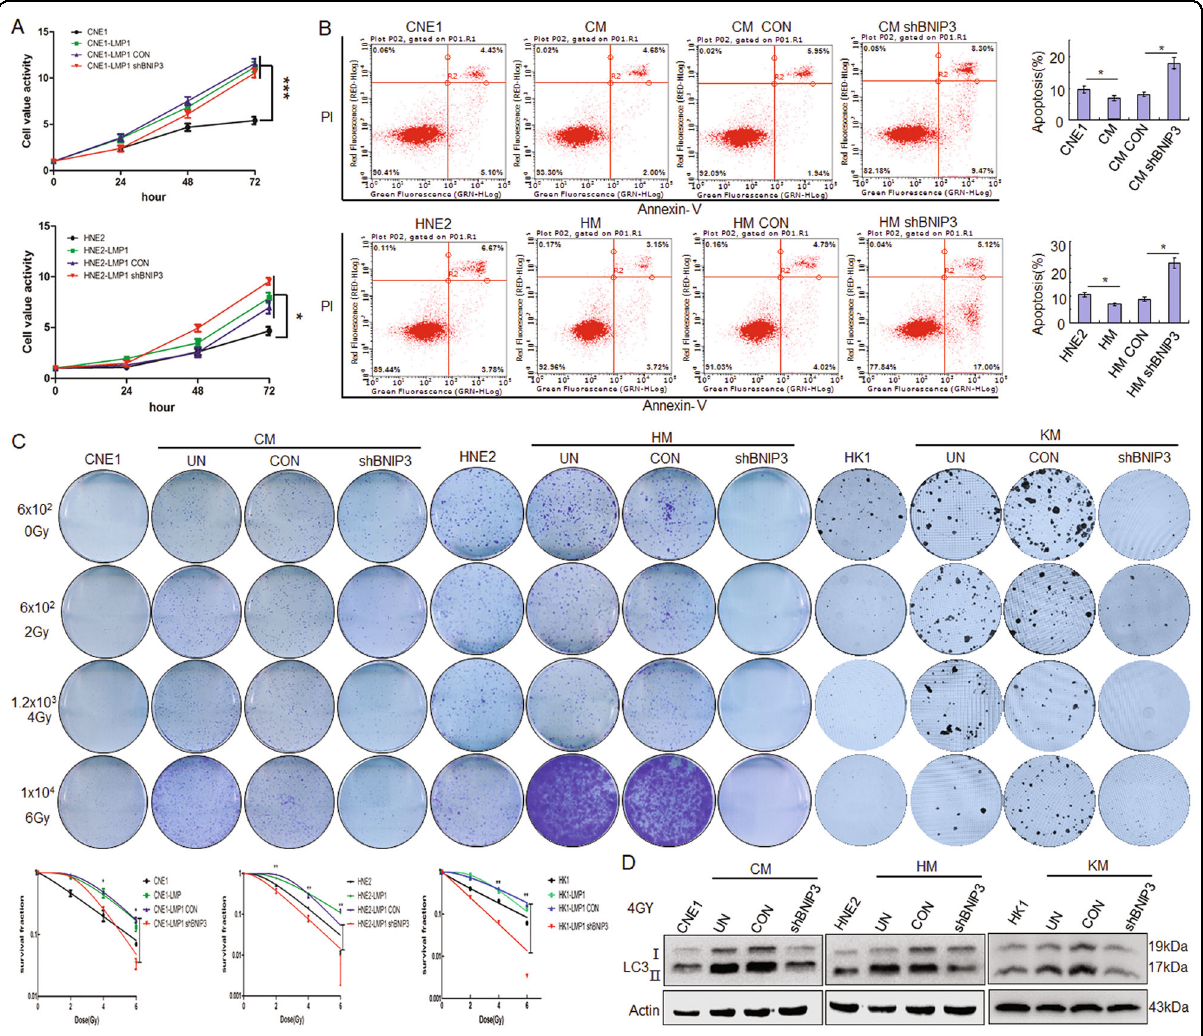
Fig. 4 LMP1 increases radioresistance of NPC cells through BNIP3. A After transfection with shBNIP3 and control for 24, 48, and 72 h, respectively, the proliferation of different NPC cells was detected by MTS assay. B After transfection with shBNIP3 and control for 24 h, fl ow cytometric analysis was performed to observe cell apoptosis. C After transfection with shBNIP3 and control for 24 h, CM, HM, and KM cells were treated with IR at 0, 2, 4, and 6 Gy and cultured for 2 weeks. Then, fi xation, staining, and colony quanti fi cation were gradually executed. Top: the representative images of hexamethylpararosaniline stained clonies. Bottom: the survival curves of CM, HM, and KM cells were fi t to the data using a linear quadratic model of radiation sensitivity. Data are expressed as means ± S.D. of three experiments. * p < 0.05, ** p < 0.01. D After transfection with GFP-LC3 for 24 h and with IR at 4 Gy, the expression of LC3 I/II in CM, HM, and KM cells by Western blots. UN untreated, CON negative